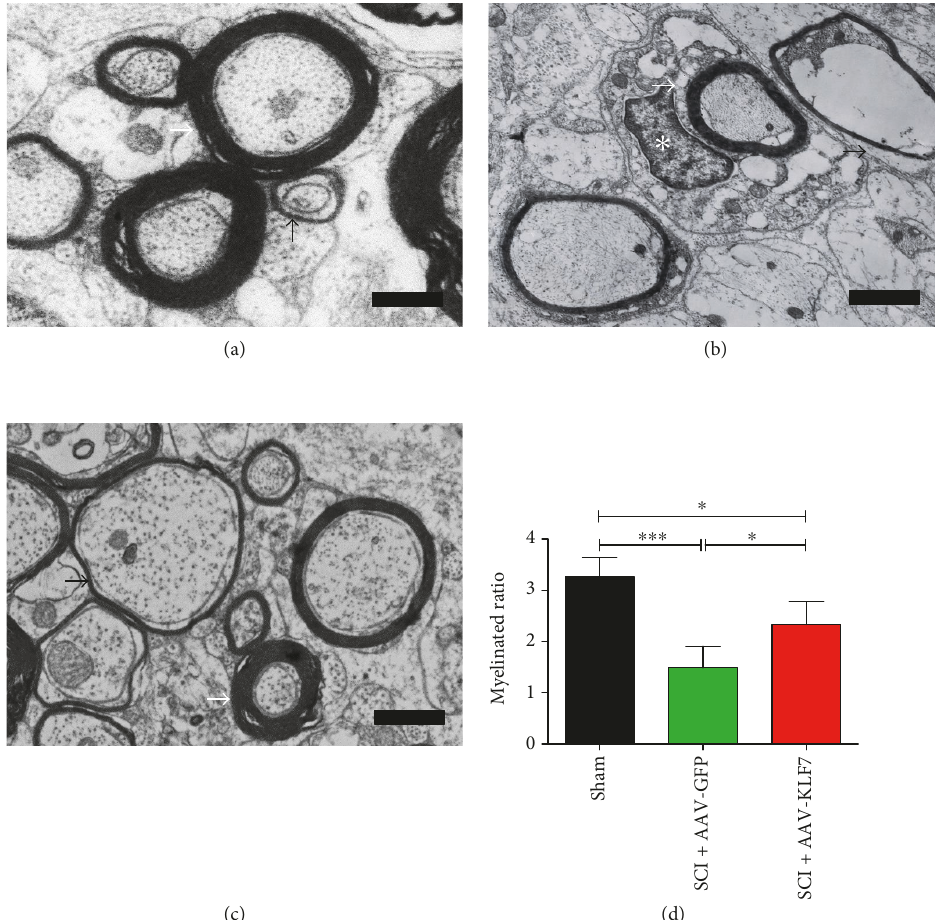
Figure 11: AAV-KLF7 promotes axon myelination around the lesion. Transmission electron microscope (TEM) analysis was used to assess remyelination of spinal axons across the sham (a), SCI+ AAV-GFP (b), and SCI+ AAV-KLF7 groups (c) ( n = 10 ). Quantitative analyses of the myelinated ratio (d). ∗ P < 0 05 , ∗∗∗ P < 0 001 , one-way ANOVA, Tukey ’ s post hoc test. Bar indicates 1 μ